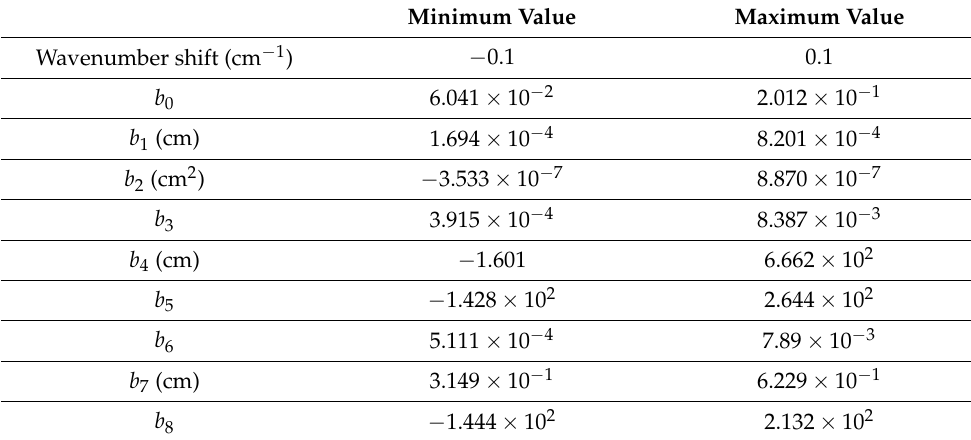
Table 1. Determined limits of the parameter space for the generation of the training data, baseline parameters and wavenumber shift